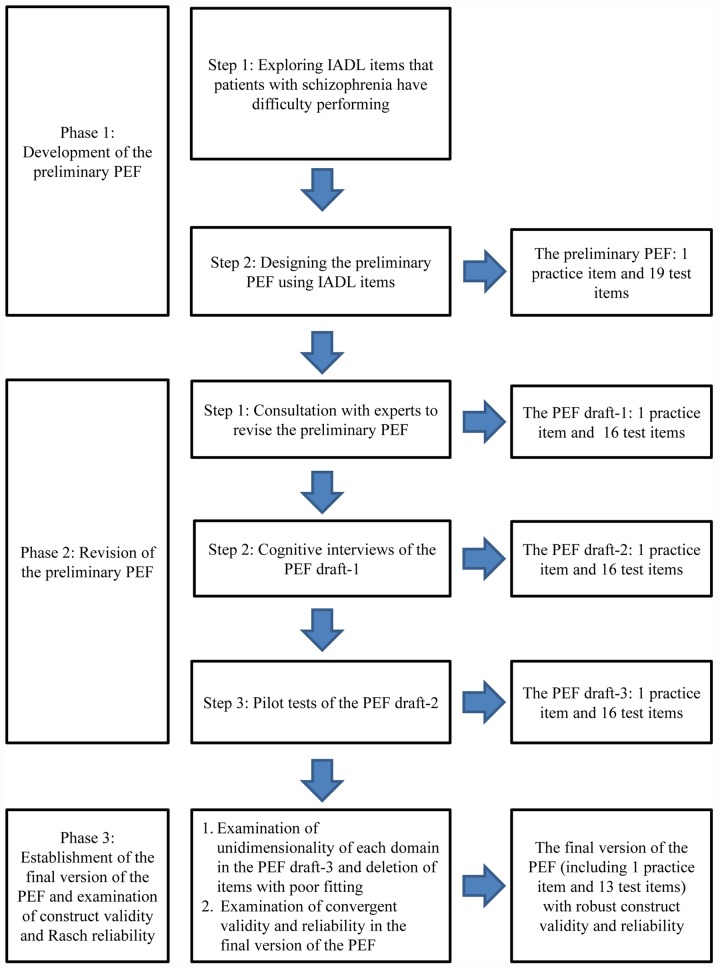
The flowchart of developing the PEF.